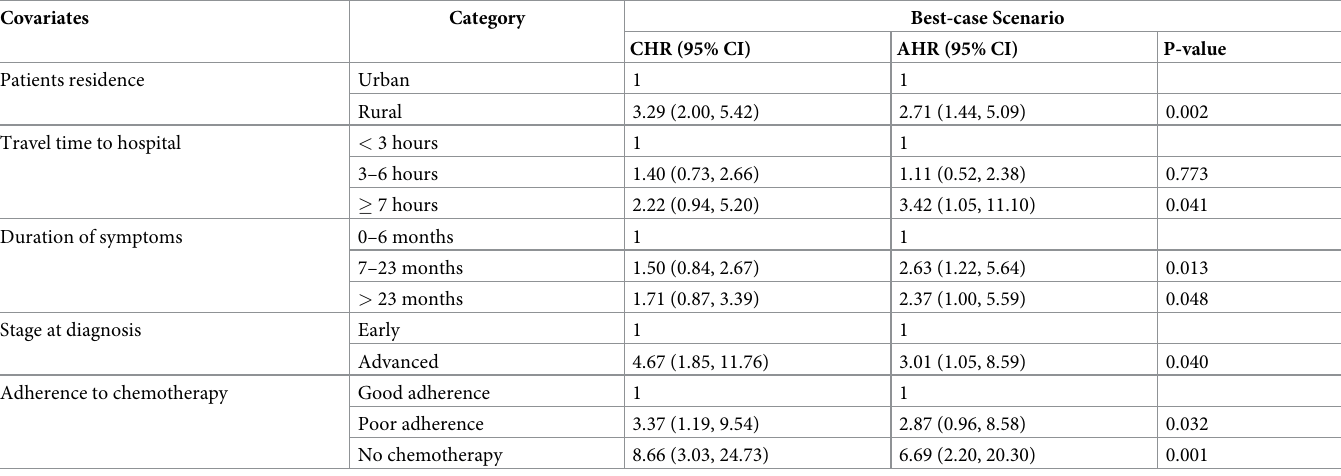
Table 4. Multivariable Cox regression analysis model for survival of female breast cancer patients in southern Ethiopia, 2013–2018 (n = 302).